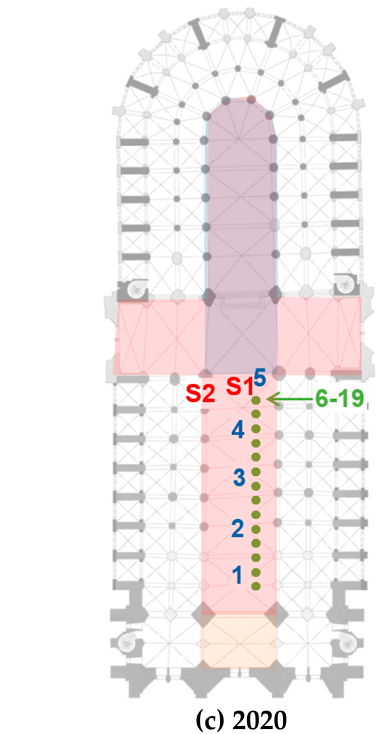
Figure 1. Measurement plans for the ( a ) 1987, ( b ) 2015, and ( c ) 2020 sessions at the Cathédrale Notre-Dame de Paris. Positions are centered under numbered source (S# (red)) and microphone (# (blue and green)) labels or at points when the measured grid too dense. The 2020 plan ( c ) also indicates in shaded regions the scaffolding (yellow), exclusion zone to people (red), and encumbered/damaged ground of the exclusion zone (blue) where it was not possible to place measurement equipment.